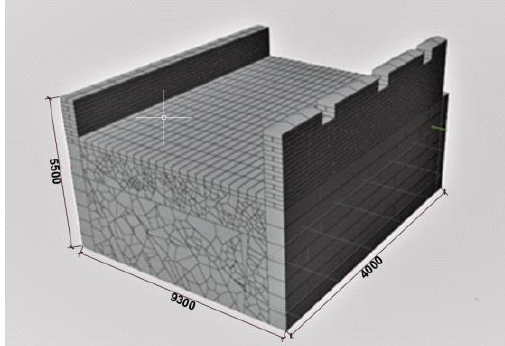
Figure 15. Flat section model of the Great Wall.